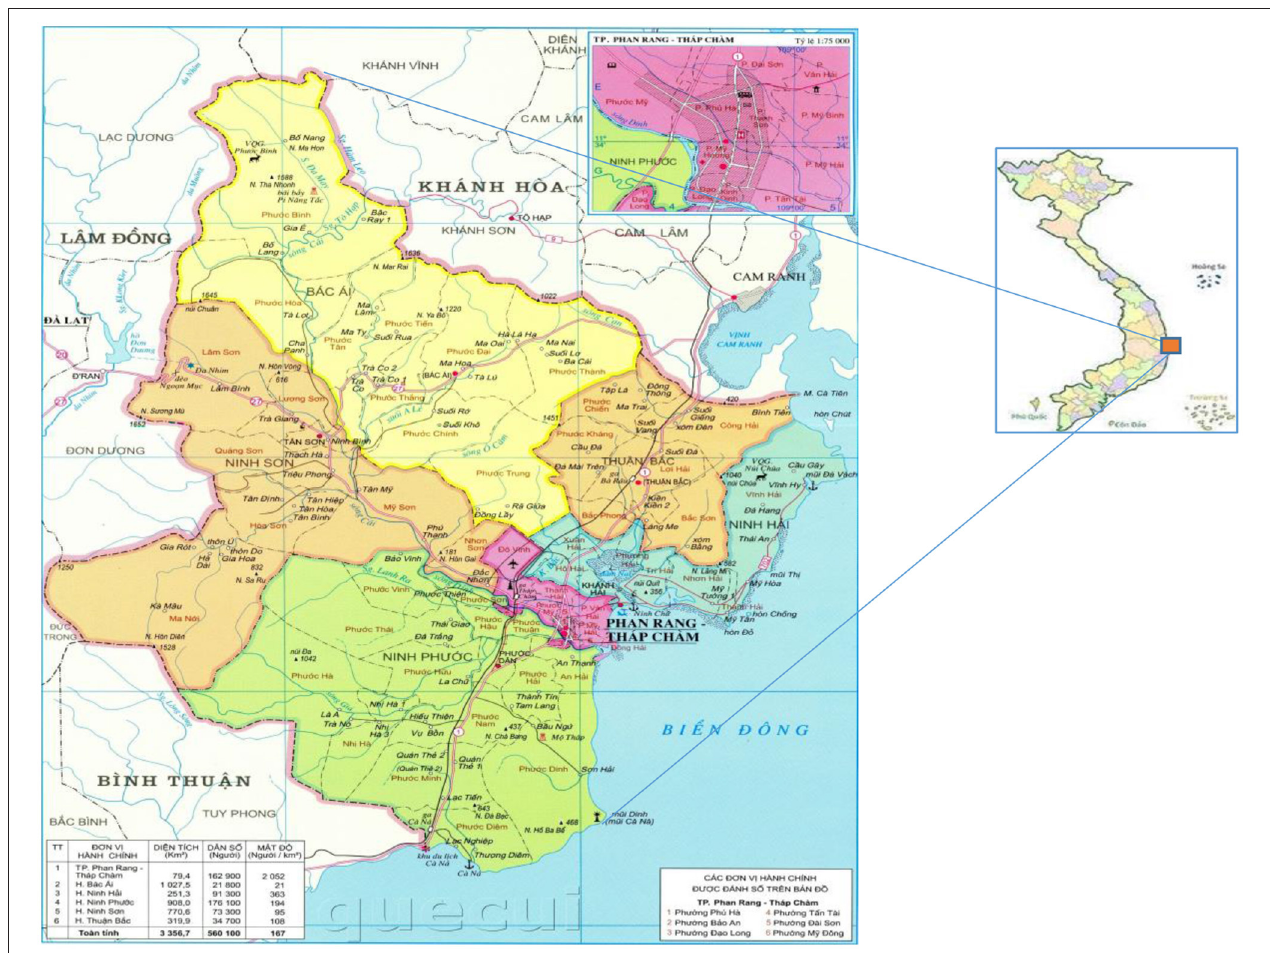
FIGURE 1 | Study area – Ninh Thuan province,